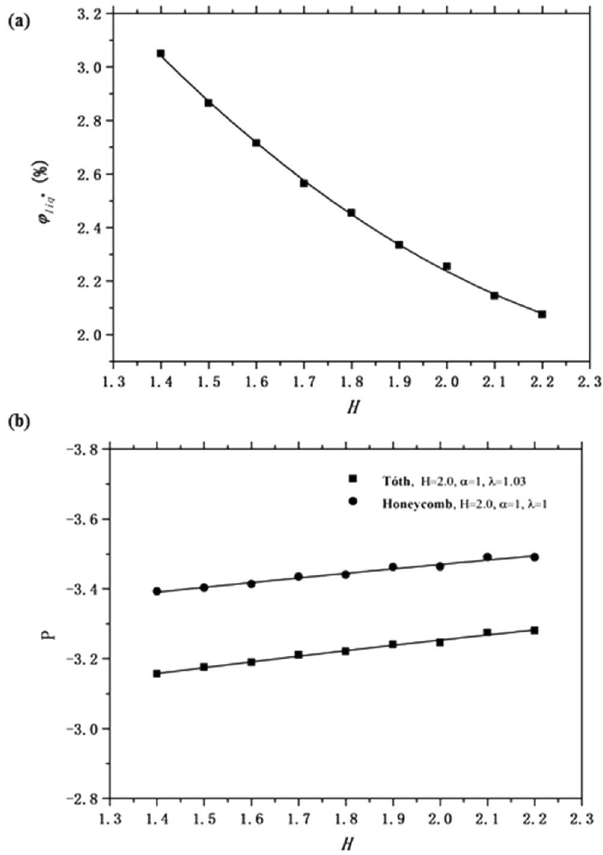
Figure 4. ( a ) The crossover liquid fraction ϕ liq * plotted as a function of the height H between the horizontal planes. ( b ) The Plateau border pressure P at the crossover liquid fractions plotted as a function of the height H .